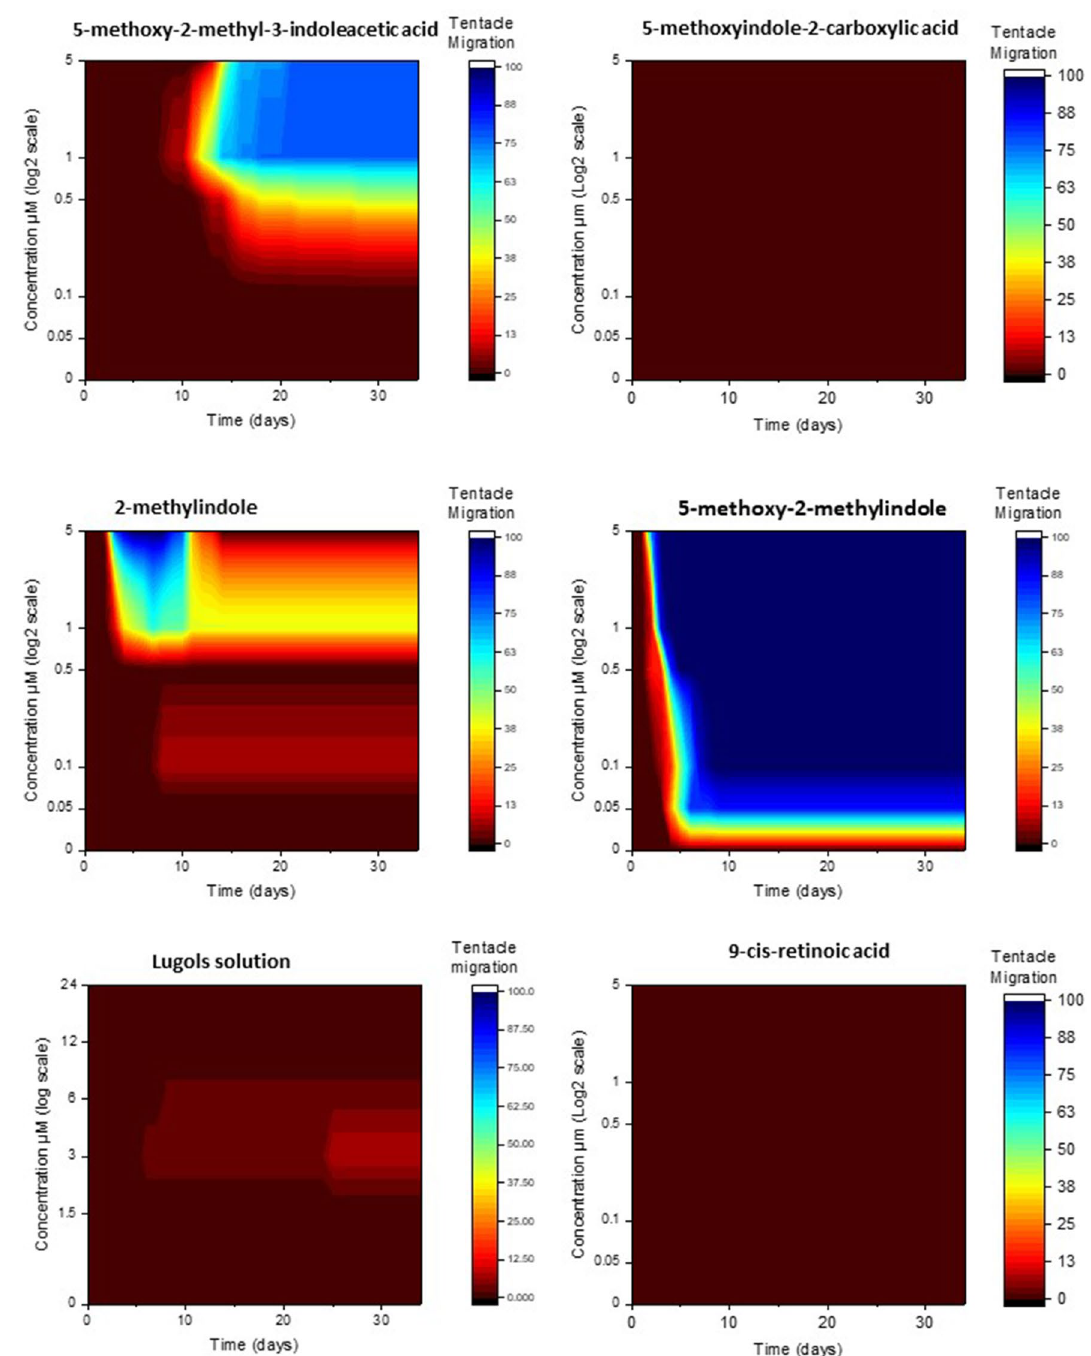
Figure 1. The cumulative percentage of Carukia barnesi polyps that displayed tentacle migration after exposure to six chemical treatments, over time in response to chemical